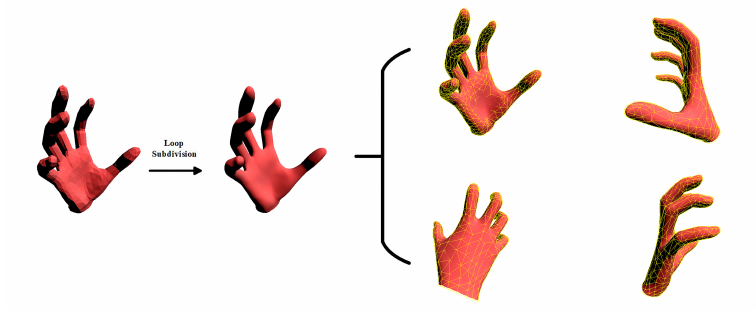
Figure 8. The original MANO hand model, the hand model applied the Loop subdivision, and four different views of the subdivided hand model with original MANO in wire-frame.